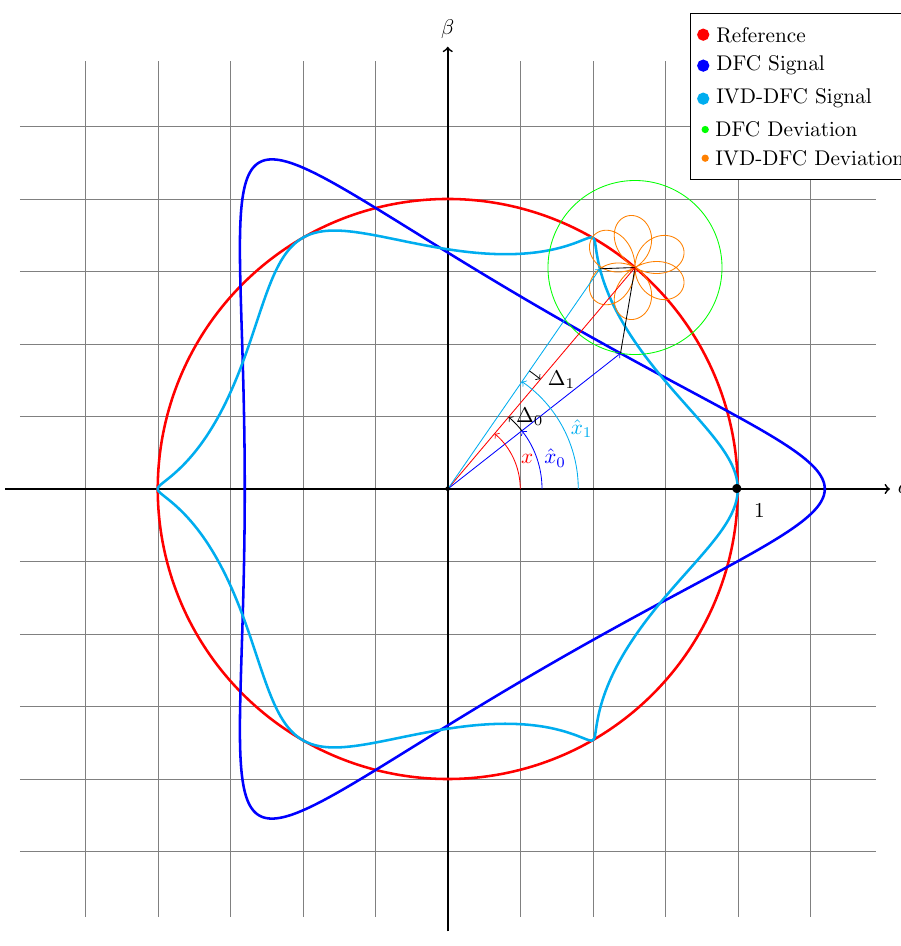
Γ Γ β and respectively on the α and β α a a